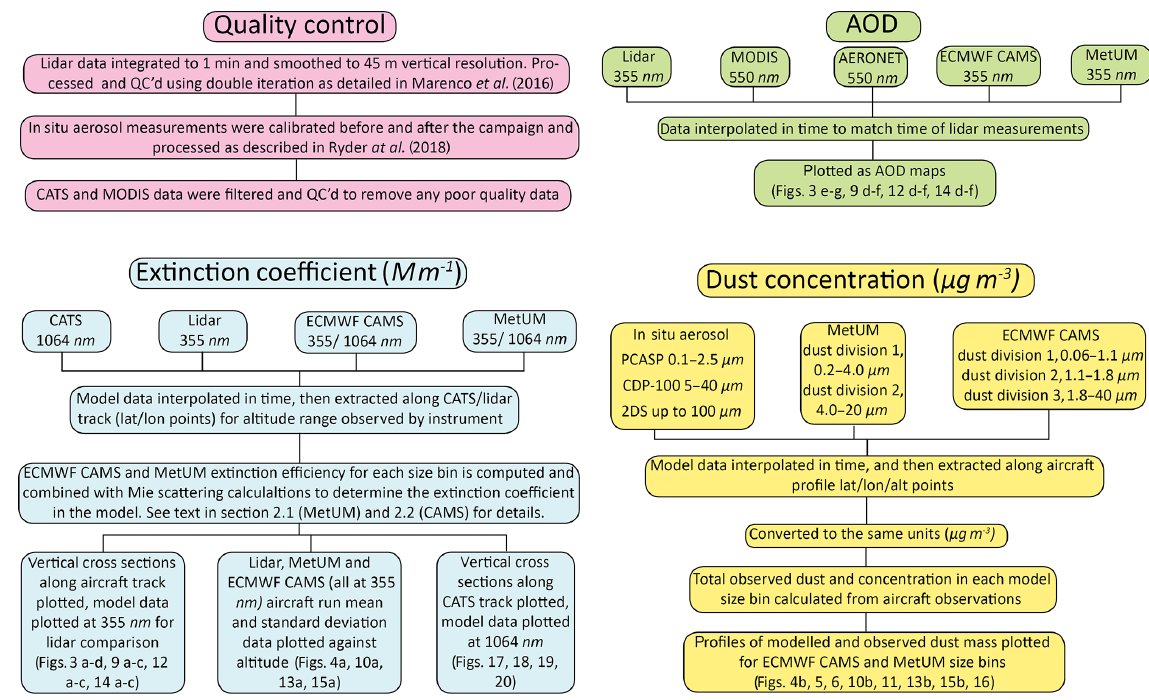
Figure 2. Flowchart of comparison